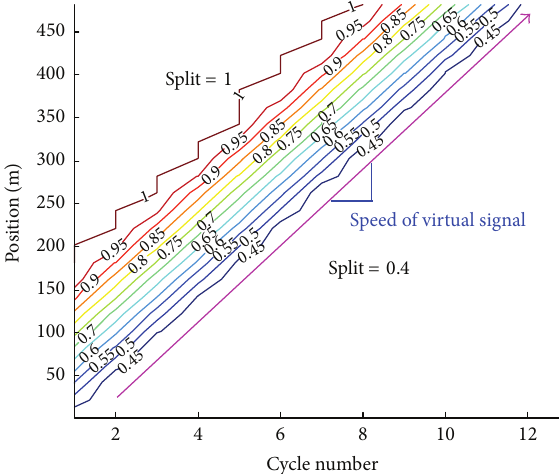
Figure 14: SVS versus split; 𝑘 𝑗 = 180 veh/km, 𝑞 𝑚 = 1800 veh/h.